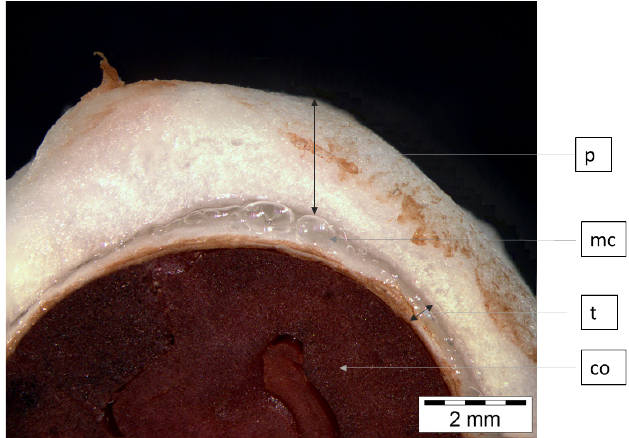
Fig. 2: Cross section of a cacao seed with pulp, mucilage caverns, testa and cotyledons, p = pulp, mc = mucilage, stored in mucilage cavern, co = cotyledon tissue, composed of two folded cotyledons. The fruit pulp (p) is derived from the endocarp. The mucilage (mc) is found in the outer layer of the testa (t). The cotyledon tissue (co) is surrounded by the testa (see Fig. 3 for greater detail). The boundary between the endotesta and the exotesta as seen in Fig. 3 is not seen in Fig. 2 because the magnification is not sufficiently high.